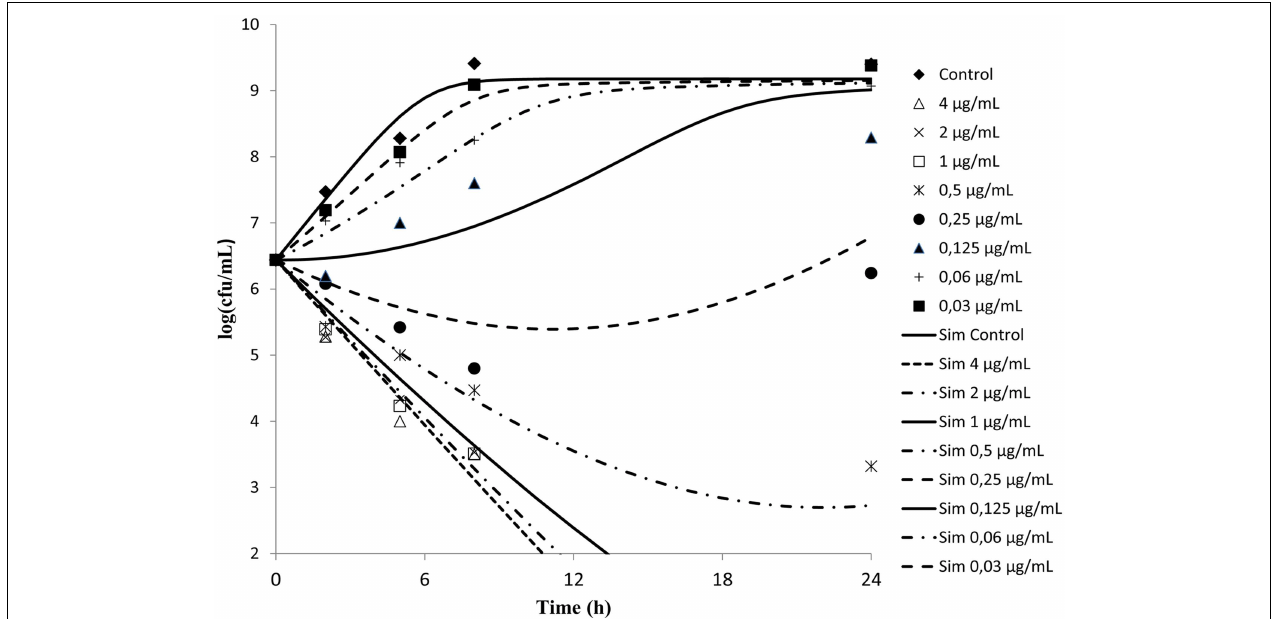
FIGURE 3 | Ex-vivo antibacterial activity of cefquinome in serum of cattle against staphylococcus aureus after intravenous administration ( n = 6 ). The concentration of cefquinome in serum at different time interval shows its effect on staphylococcus aureus.